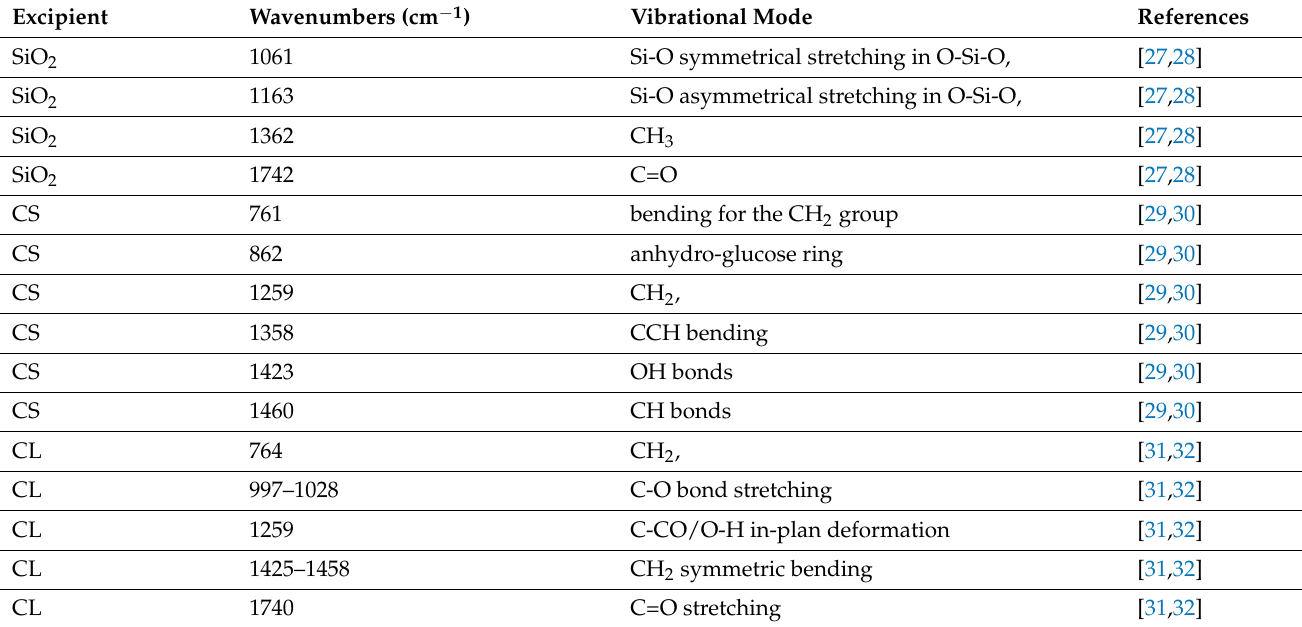
Table 3. The main IR bands of excipients of LO and their